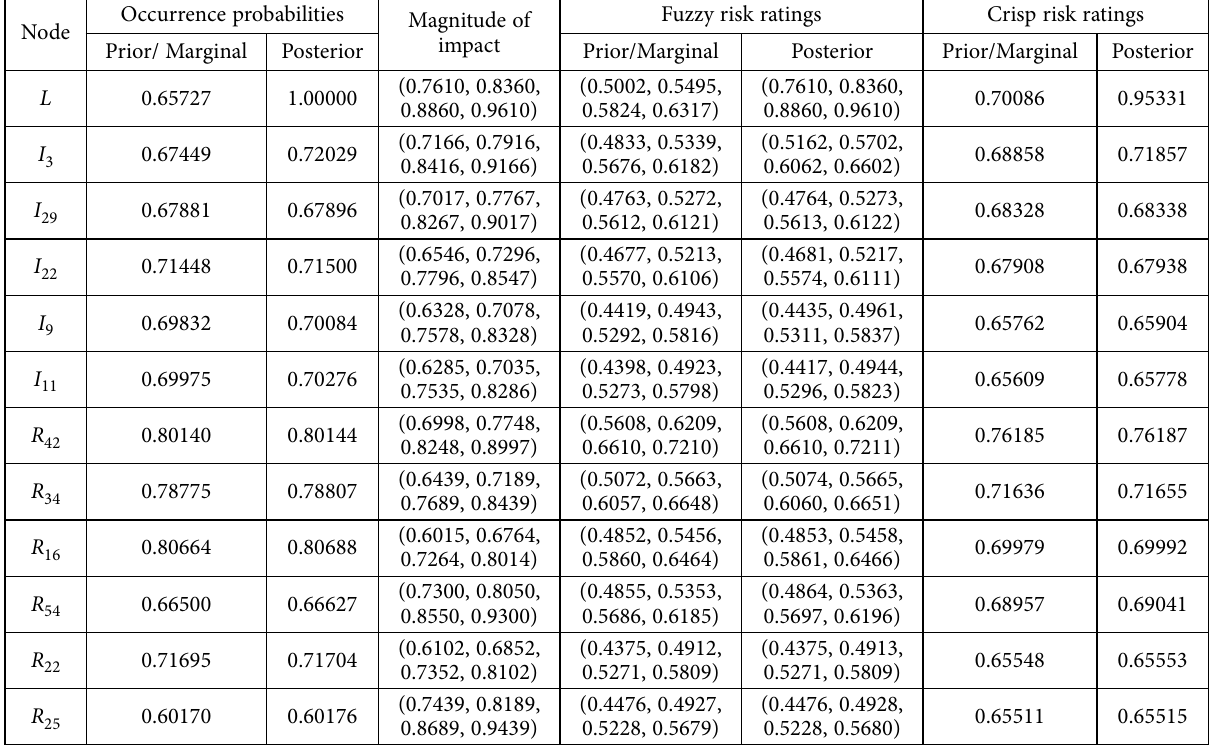
Table 3. FBBN-based RA results of the nodes (i.e., leaf, intermediate and root nodes) in the risk network for the Ankara-Istanbul high-speed railway project (samples) Node